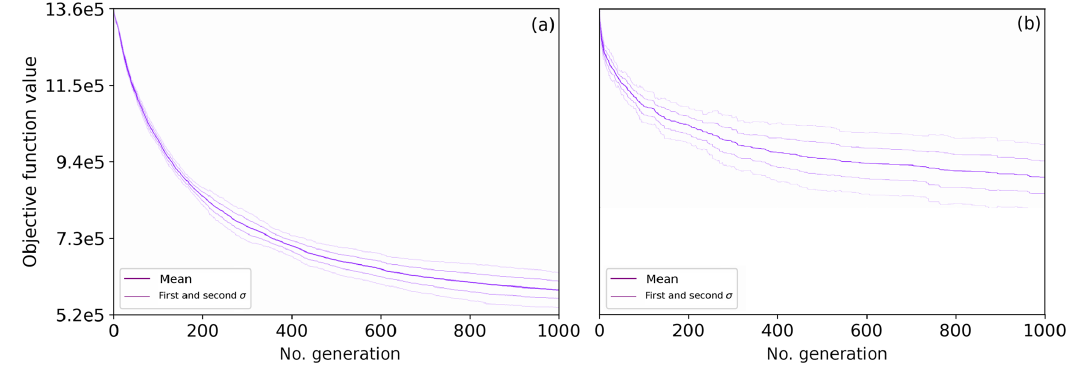
Figure 4. Convergence curves (mean, first and second standard deviations of 10 runs) obtained for tests RMNPC2 and FM4. (a) One-point crossover, proximity mutation and flatiron mutation (FM4). (b) Random mutation and one-point crossover